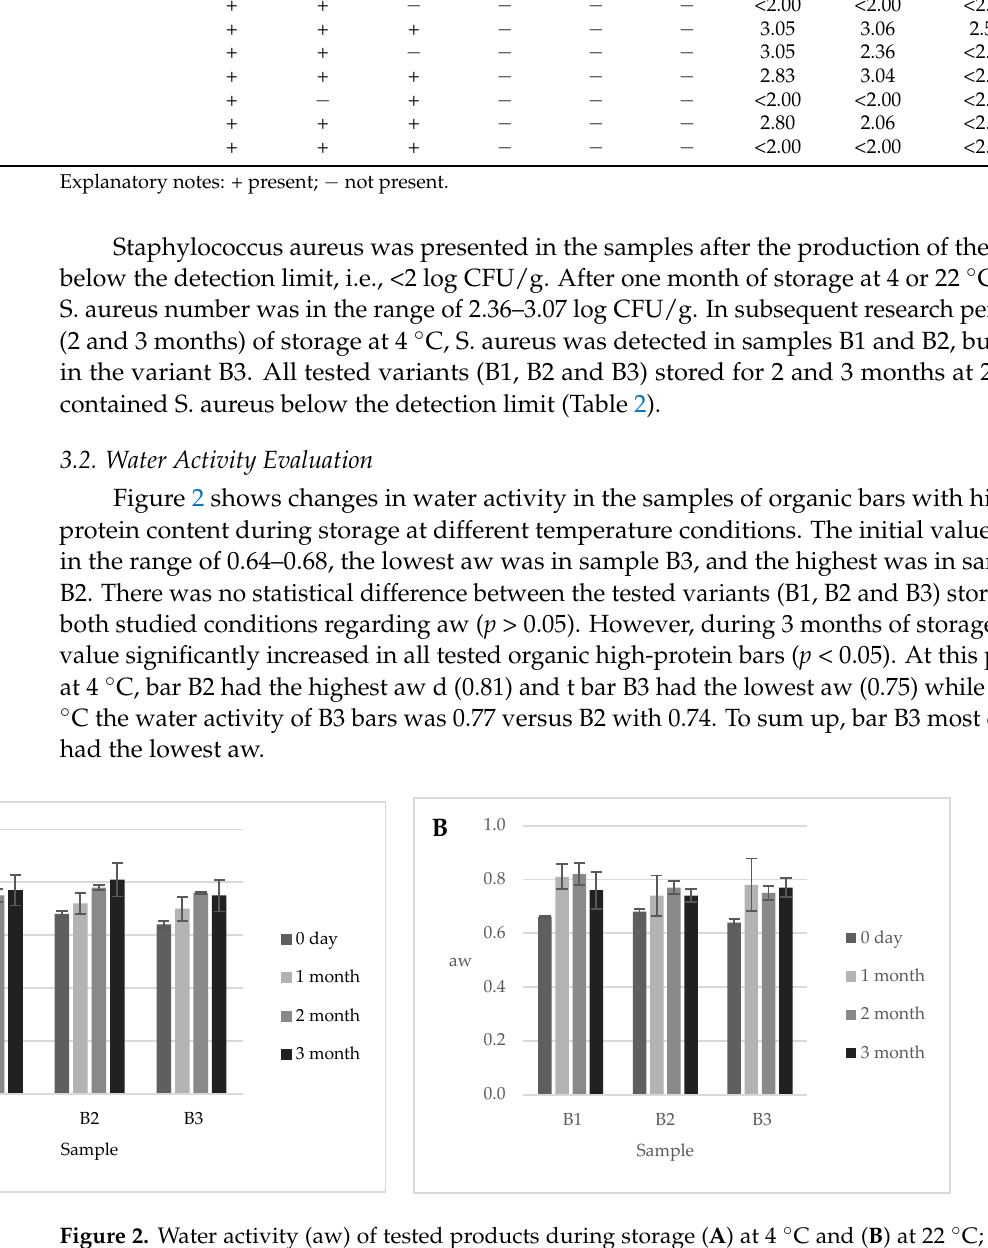
Figure 2. Water activity (aw) of tested products during storage ( A ) at 4 ◦ C and ( B ) at 22 ◦ C; n = 3. Figure 2 . Water activity (aw) of tested products during storage ( A ) at 4 °C and ( B ) at 22 °C; n = 3. Bars represent mean standard error . Bars represent mean standard